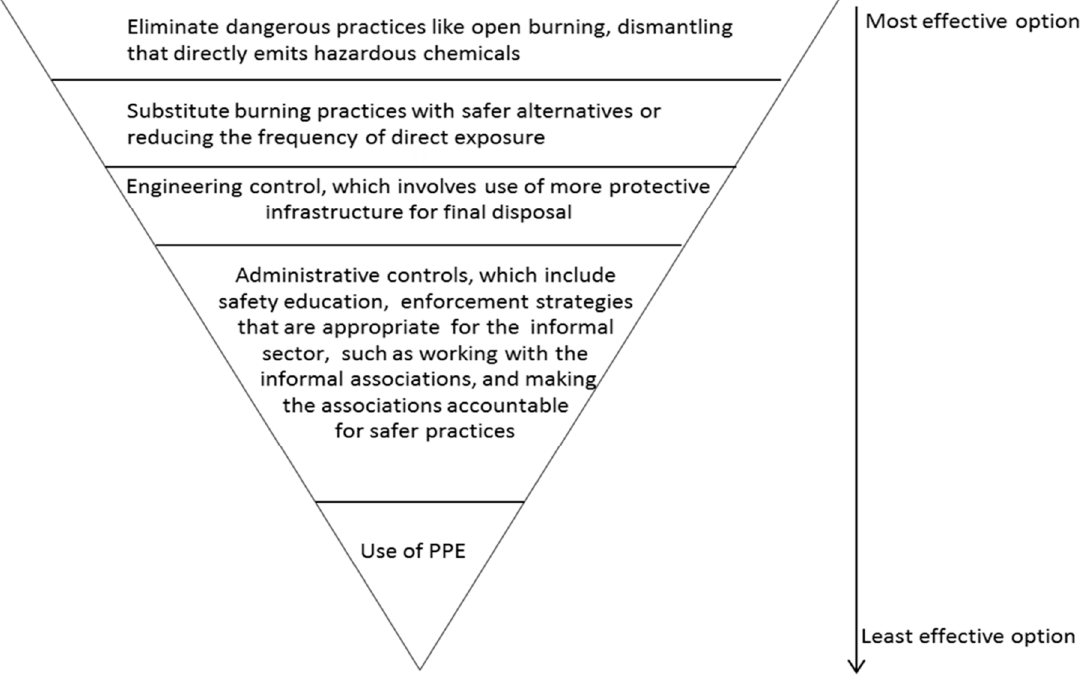
Table S1: Median PBDE concentrations (ng/kg) and Exeedance of soil and dusts across various e-waste sites in Lagos, Table S2: Median metals concentrations (mg/kg) and Exeedance of soil and dusts across various e-waste sites in Lagos, Table S3: Median PBDE concentrations (ng/kg) and Exeedance of soil and dusts across